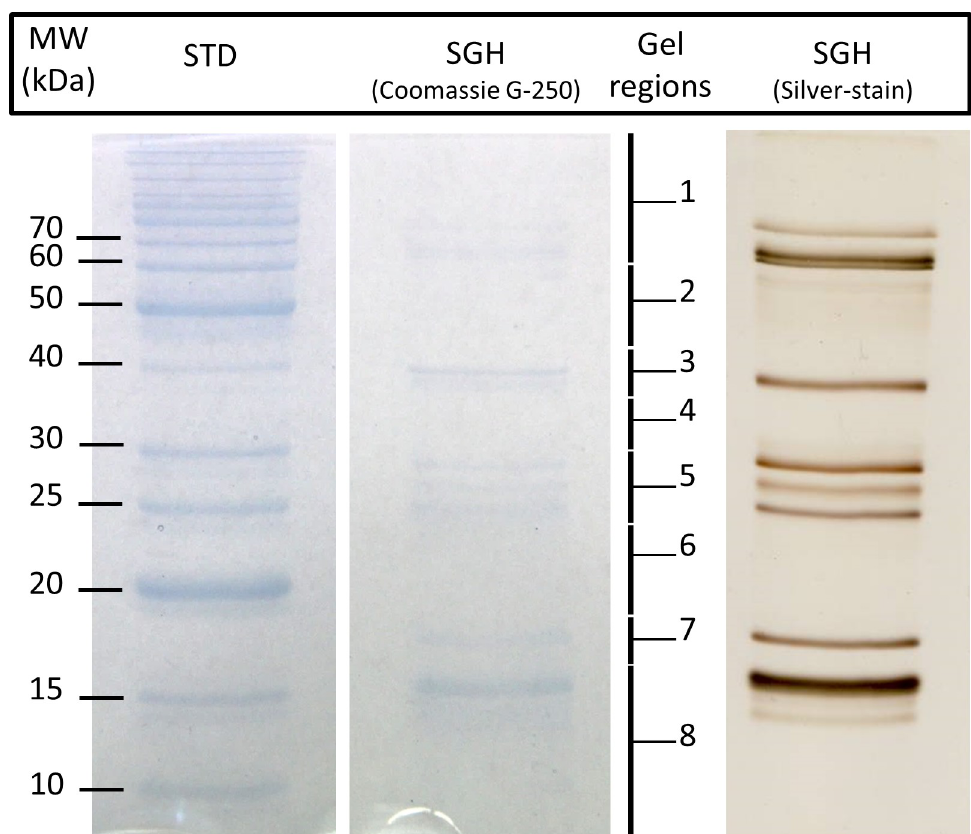
Fig 3. Coomassie G-250 and silver-stained SDS-PAGE gel (12% polyacrylamide). The Simulium damnosum s.l. salivary proteins were separated under non-reducing conditions together with a standard (STD) and stained by Coomassie G-250 and the silver-stain method. The separated blackfly salivary gland proteins range from 10 to 80 kDa. Eight different regions were cut from the Coomasssie G-250-stained gel and subjected to mass spectrometry analysis, indicated by ‘Gel regions’. MW: molecular weight; kDa: kiloDaltons; STD: Standard; SGH: Salivary Gland